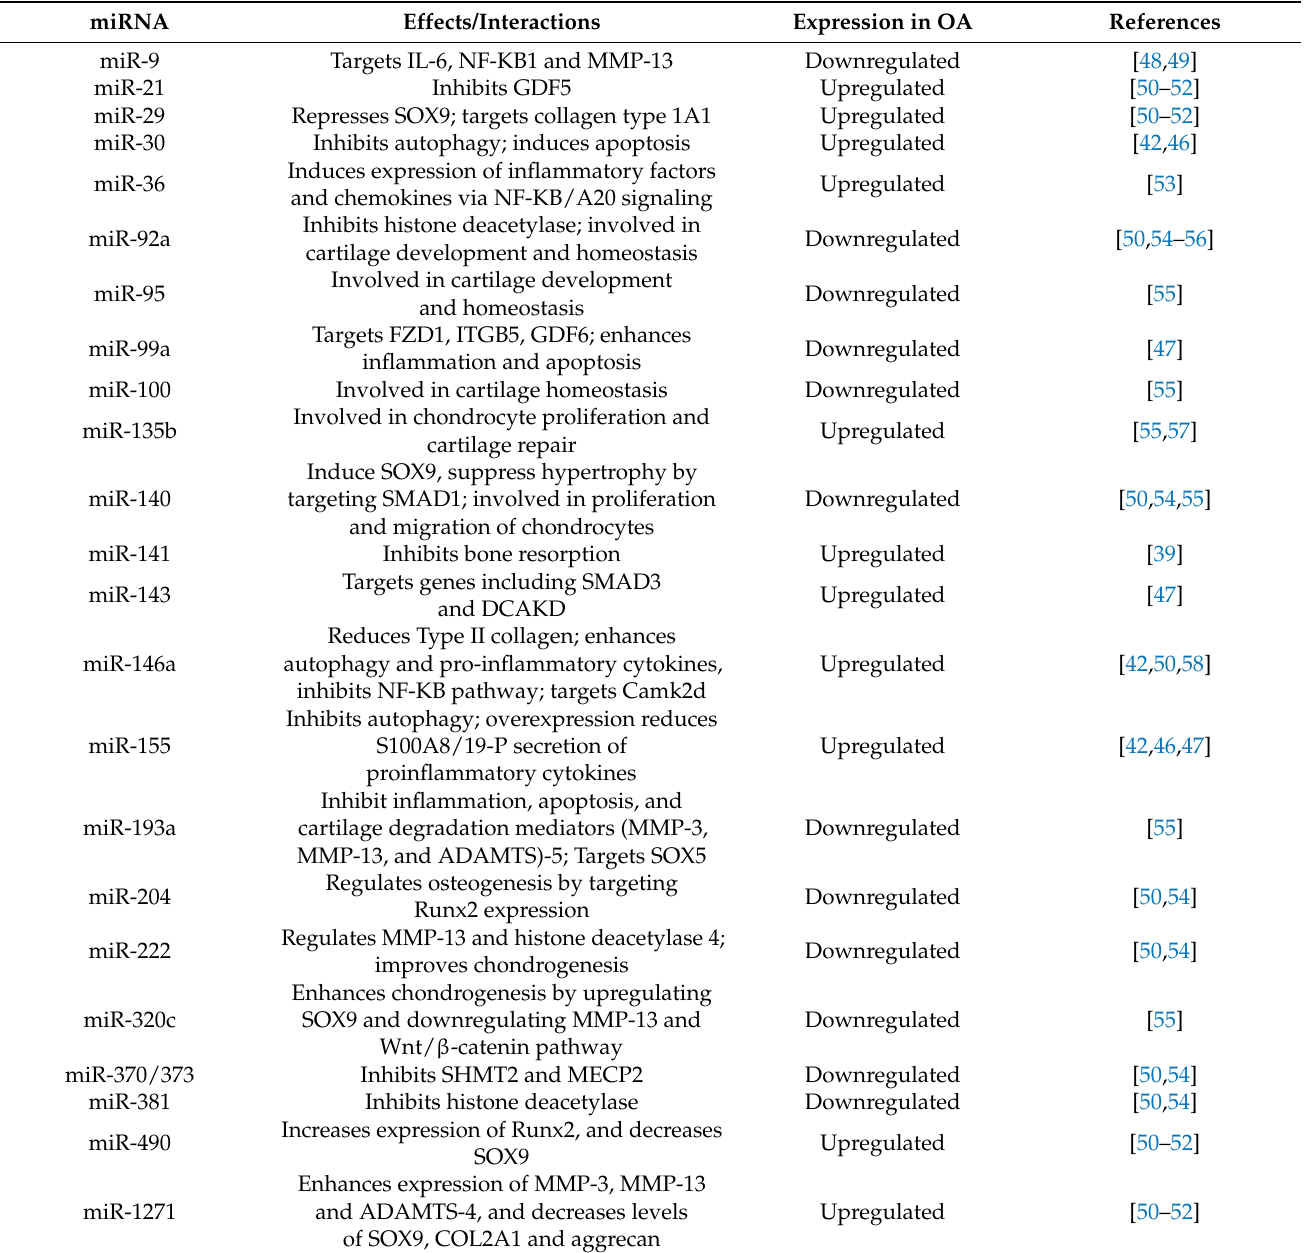
Table 1. MicroRNAs differentially expressed in OA resulting from potential impaired expression by